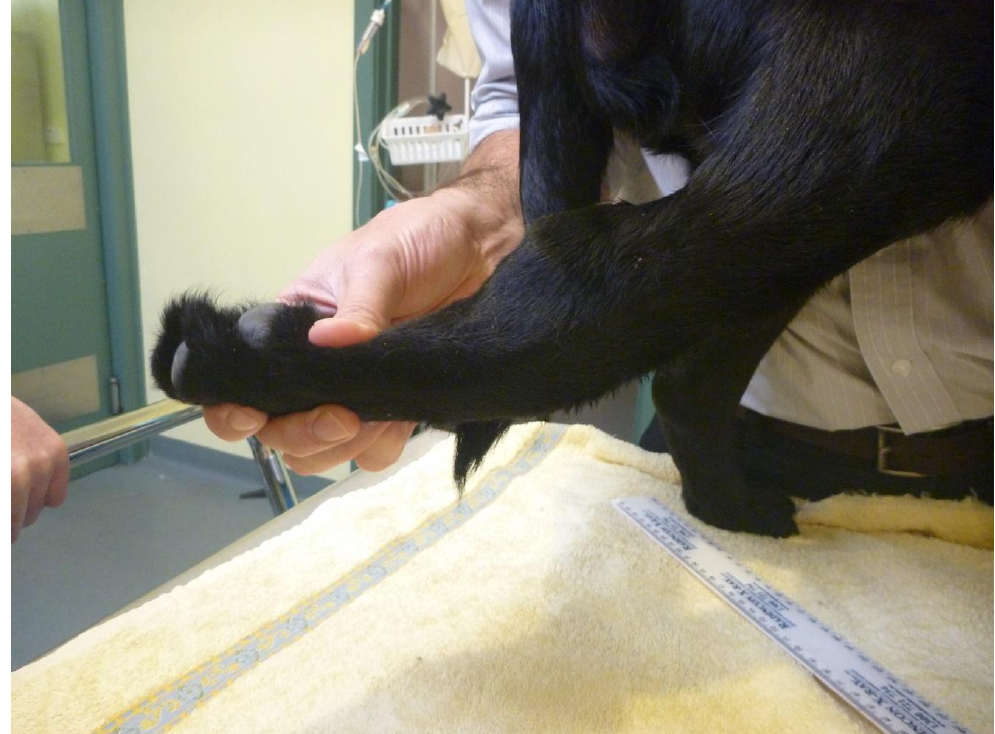
Figure 1. Case 1, Joint hypermobility of the tarsus and metatarsus.